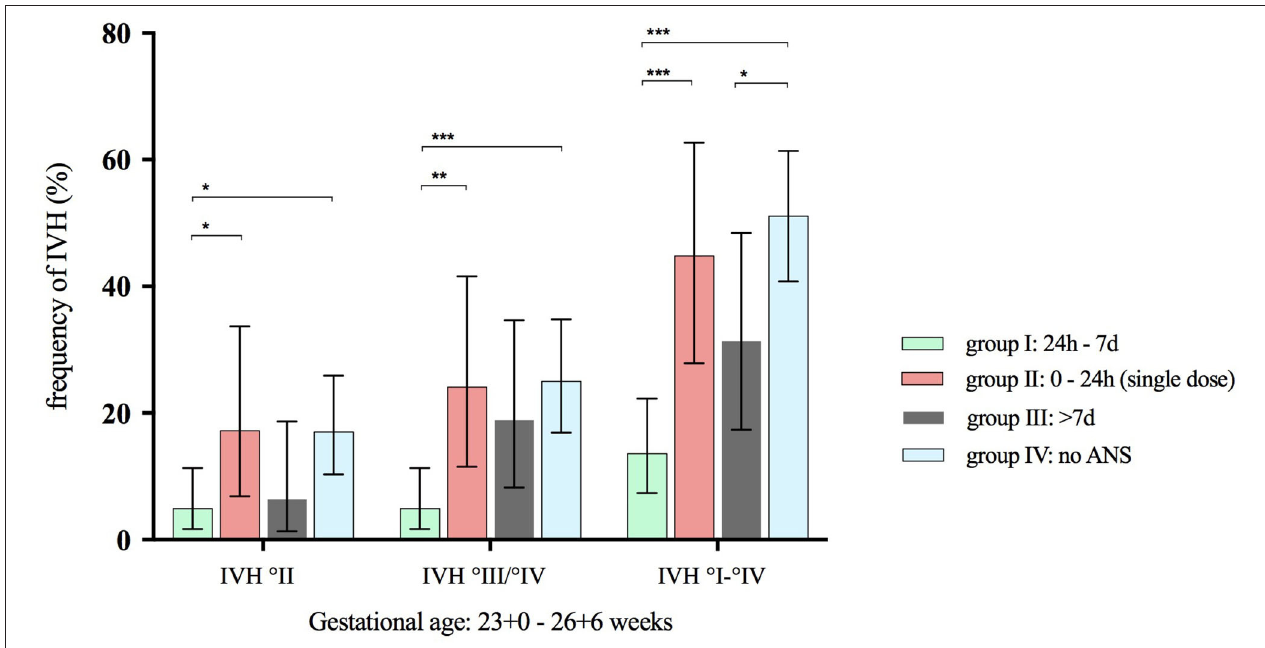
FIGURE 3 | Frequency of IVH grades stratified to ANS exposure groups. ANS, antenatal steroids; IVH, intraventricular hemorrhage. Horizontal lines connect subgroups with significant differences; * p < 0.05, ** p < 0.01, *** p < 0.001; error bars show 95% confidence interval; n = 309 infants with a gestational age from 23 + 0 to 26 +